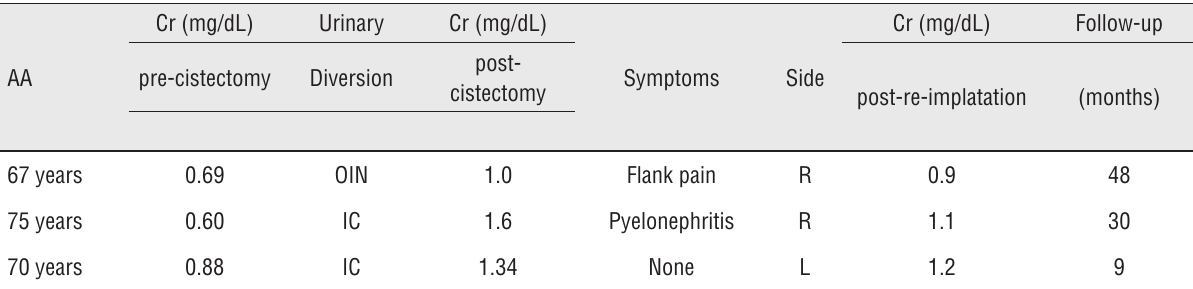
Table 1 - Study Group